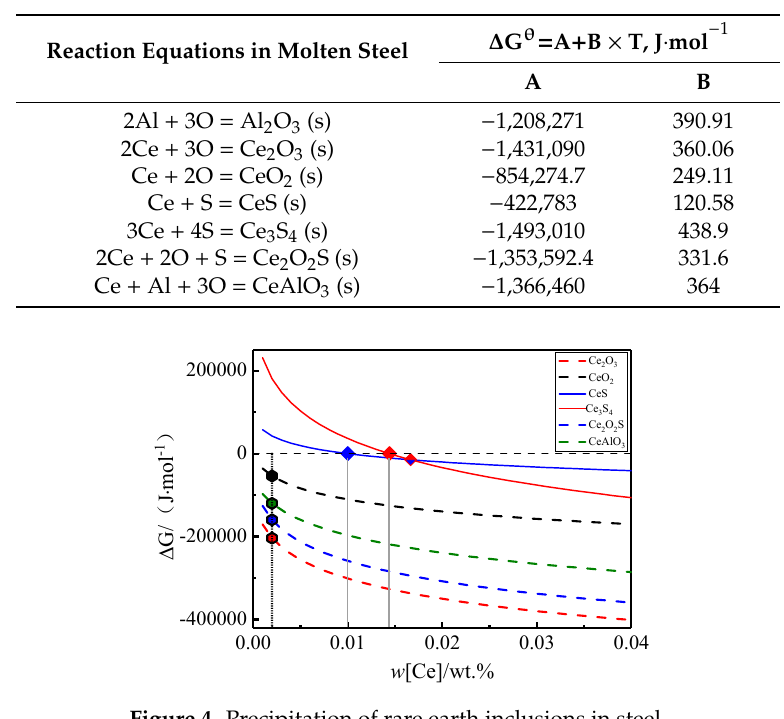
Figure 4. Precipitation of rare earth inclusions in steel.